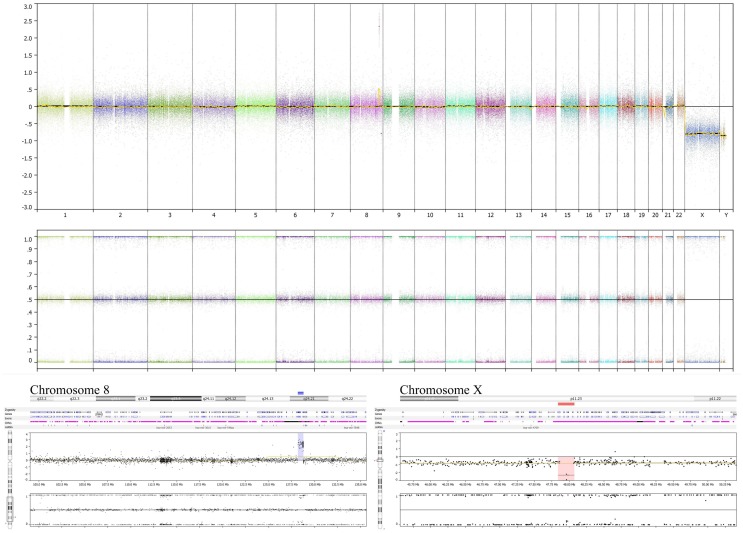
Tumor specimen obtained at diagnosis has MYC amplification and deletion at Xp11.2. OncoScan results using MIP technology to detect copy number and loss of heterozygosity information of the original diagnostic tumor FFPE material demonstrates the amplified MYC locus at 8q24.21 (lower left panel) along with deletion of the SSX6 region at Xp11.2 (lower right panel). The deletion at Xp11.2 in this boy’s FFPE tumor sample, without detection of a non-deleted signal, suggests that the FFPE specimen analyzed comprised nearly 100% tumor cells, without significant contribution from non-tumor cells. This analysis does not show chromosome 17 or 11q alterations (upper panel).